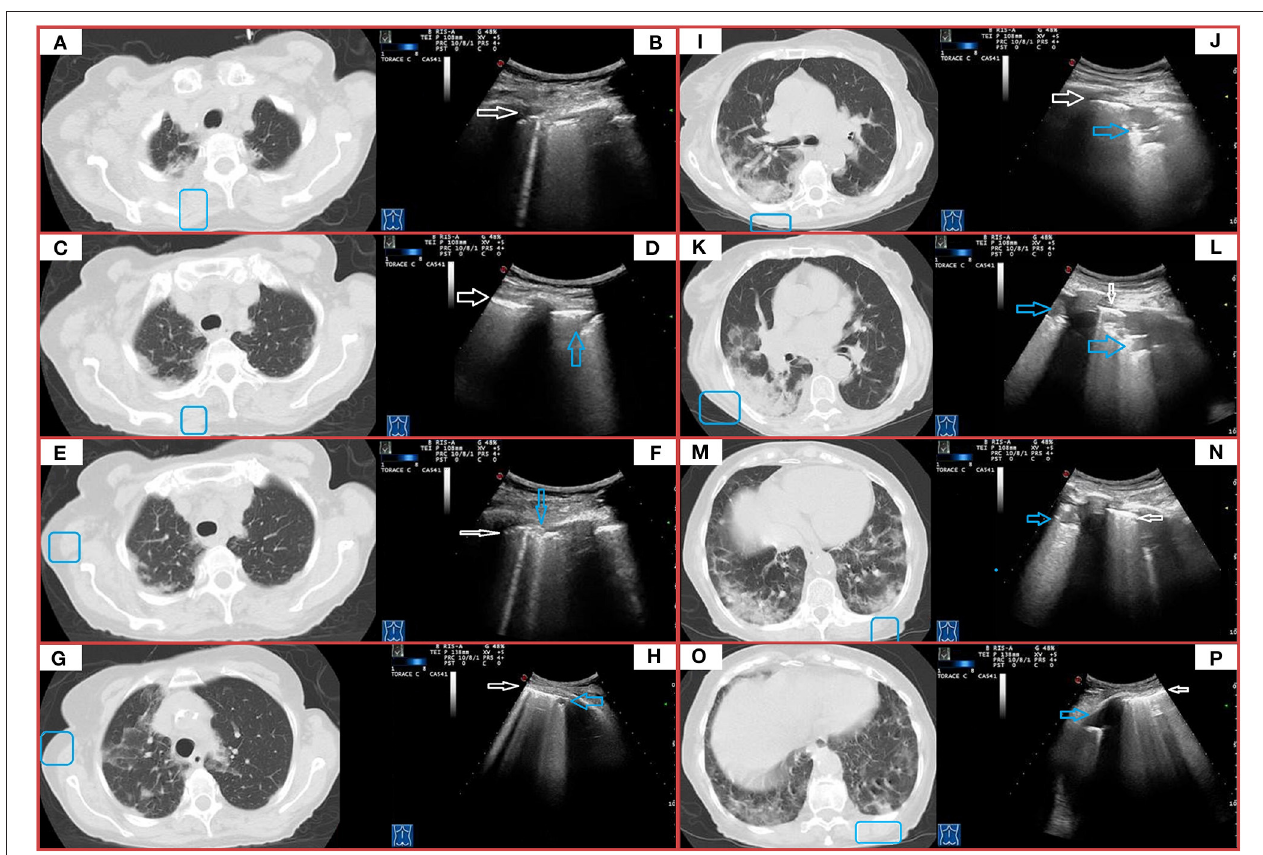
FIGURE 6 | CT and TUS findings in severe COVID-19 pneumonia. A 72-year-old male patient presenting in ED with 1 week fever, dyspnea, cough, and fatigue. The RT-PCR assay on nasopharyngeal swab confirmed the suspect for COVID-19 pneumonia. In (A) , axial scan passing through the apical segments of right and left upper lobes shows a mixed pattern of ground glass opacities and minimal consolidations with subpleural and posterior distribution extending in the retroscapular and retrocostovertebral areas. In (B) , ultrasound scan with a convex probe (6 MHz) and thoracic setting, corresponding to the blue box in the respective CT scan, allows to see an irregular pleural line (white arrow) with a single B-line (corresponding the US-accessible portion of the lesion). In (C) , axial scan passing through the right and left upper lobes shows patchy subpleural ground glass lesions, also extending in the retroscapular and retrocostovertebral areas, mostly on the right side. In (D) , ultrasound scan with a convex probe (6 MHz) and thoracic setting, corresponding to the blue box in the respective CT scan, shows a thickened hyperechoic pleural line (white arrow) with a mixed hypoanechoic subpleural irregular nodulation (blue arrow), corresponding to the US-accessible portion of these patchy subpleural ground glass lesions. In (E) , axial CT scan passing through the upper lobes shows patchy subpleural ground glass opacities, with prevalent posterior distribution and extending also in the retroscapular areas in the right upper lobe and a focal ground glass opacity localized in the subpleural parenchyma of the paramediastinal region in the right upper lobe. In (F) , ultrasound scan with a convex probe (6 MHz) and thoracic setting, corresponding to the blue box in the respective CT scan, shows a thickened hyperechoic pleural line (white arrow) with two B-line and a focal subpleural hyperechoic micronodulation (blue arrow) corresponding to the US-accessible part of the retroscapular lesion. In (G) , axial CT scans passing through the upper lobes shows patchy and diffuse areas of ground glass opacities, with a minimal involvement of the retroscapular area, in the right upper lobe. In the left upper lobe, a mixed area of ground glass and consolidation is visible in the subpleural parenchyma of paramediastinal region. In (H) , ultrasound scan with a convex probe (6 MHz) and thoracic setting, corresponding to the blue box in the respective CT scans, shows a thickened hyperechoic pleural line (white arrow) with coalescent B-lines and a subpleural hypoechoic micronodulation, corresponding the US-accessible part of these patchy and diffuse areas of GGO. In (I) , axial CT scan passing through the level of the carina shows subpleural mixed consolidation and ground glass lesions in the apical segment of the right lower lobe and the lateral regions of the right upper lobe. On the left side, minimal subpleural ground glass opacities are present in the apical segment of the lower lobe. In (K,M,O) , axial CT scans passing through the middle-lower region show a large and confluent consolidation mixed with ground glass opacities, mostly located in the posterior regions of the middle and right lower lobes. Both lower lobes show multiple confluent areas of ground glass opacities in a predominant subpleural and posterior distribution, associated with minimal consolidations. In (J,L,N,P) , ultrasound scans with a convex probe (6 MHz) and thoracic setting, corresponding to the blue boxes in the respective CT scans, show a thickened hyperechoic pleural line (white arrow) with mixed hypoechoic subpleural consolidations (blue arrows), representing the portion of these consolidations completely adhering to the pleural